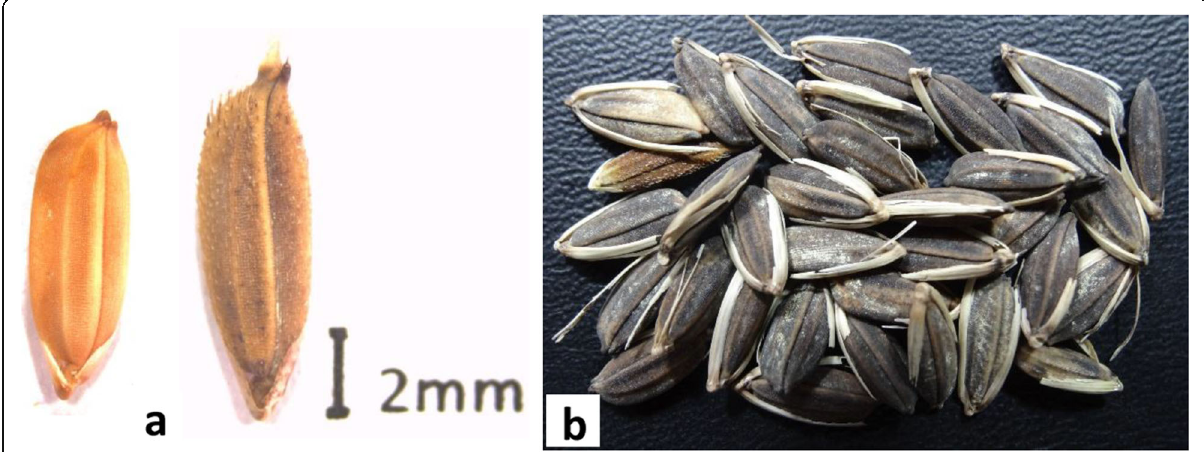
Fig. 2 O. glaberrima and O. barthii seeds. a African rice exhibits an unusual domestication phenomenon where it has smaller seeds (left) than its putative progenitor (right) b Undehusked seeds of African